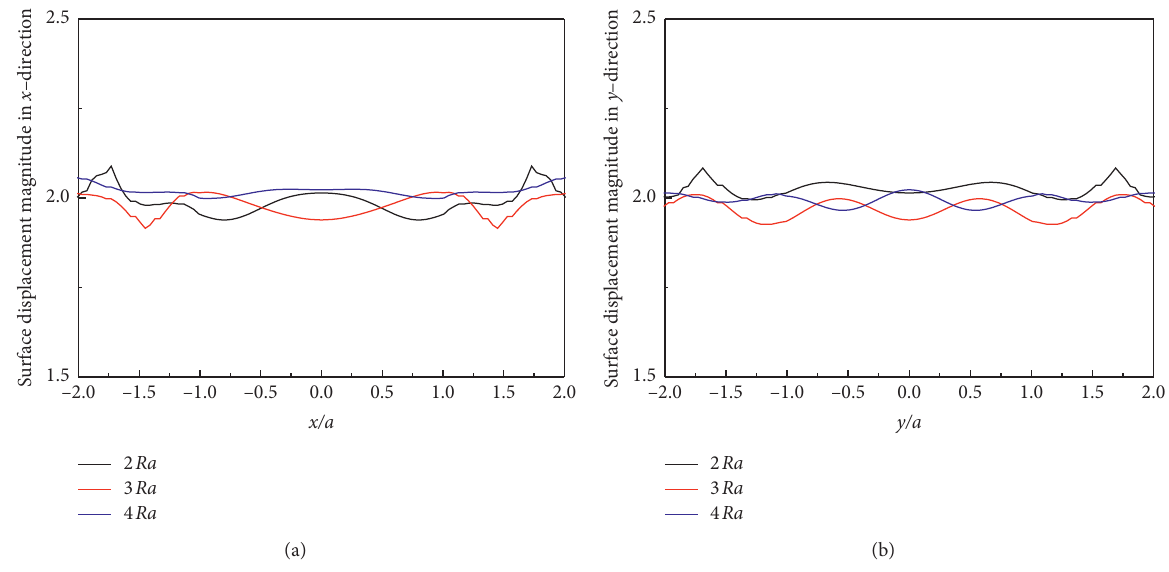
Figure 3: The x -direction displacement amplitude of the surface node of the free field: (a) the x -axis; (b) the y -axis.